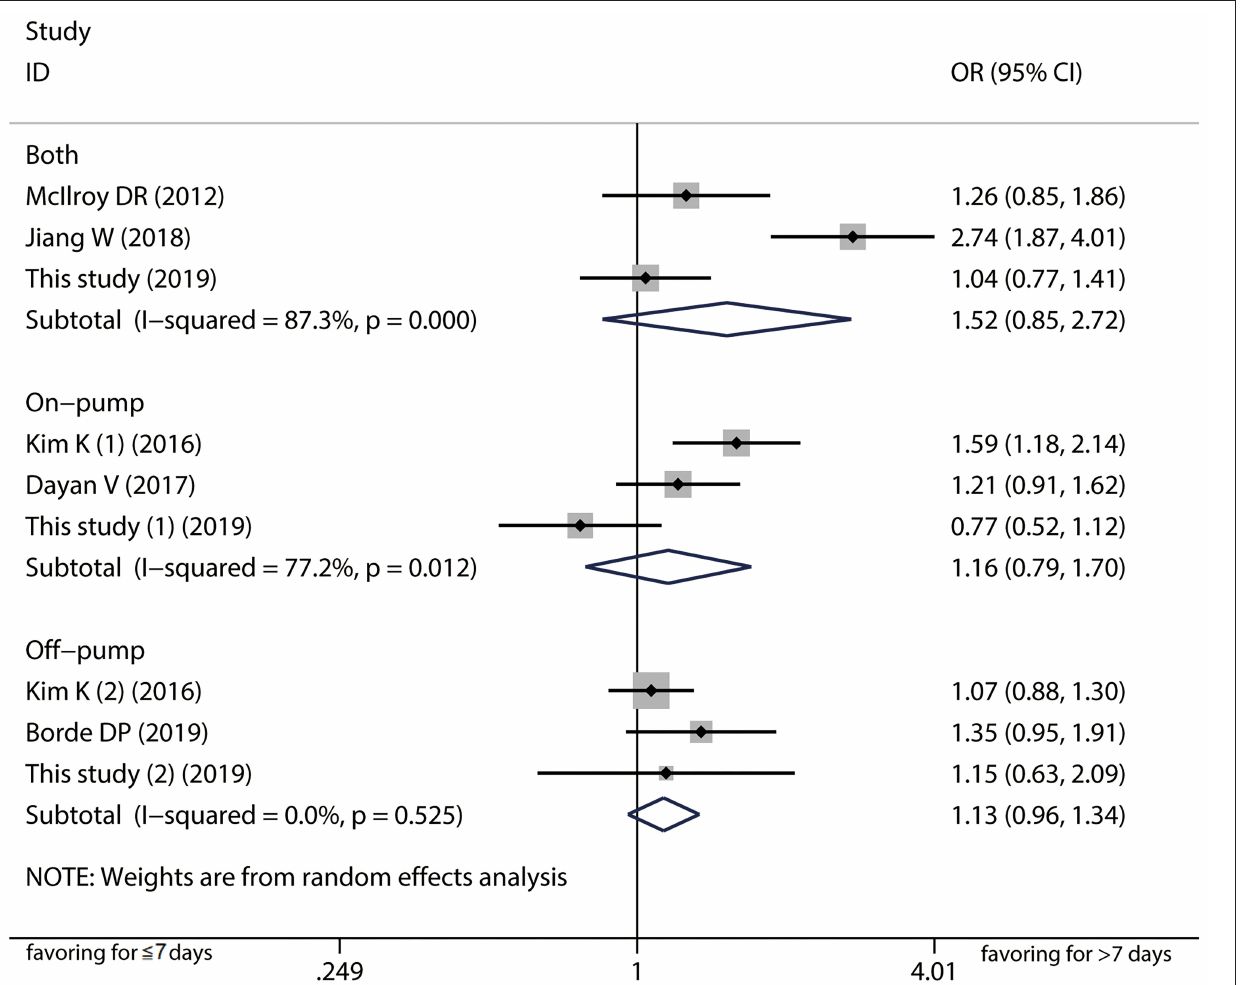
FIGURE 2 | Forest plot comparing ≤ 7-day and > 7-day intervals stratified by cardiopulmonary bypass in the meta-analysis. The results indicated AKI risk did not differ between a time interval ≤ 7 days vs. > 7 days in the on-pump, off-pump, and both groups.